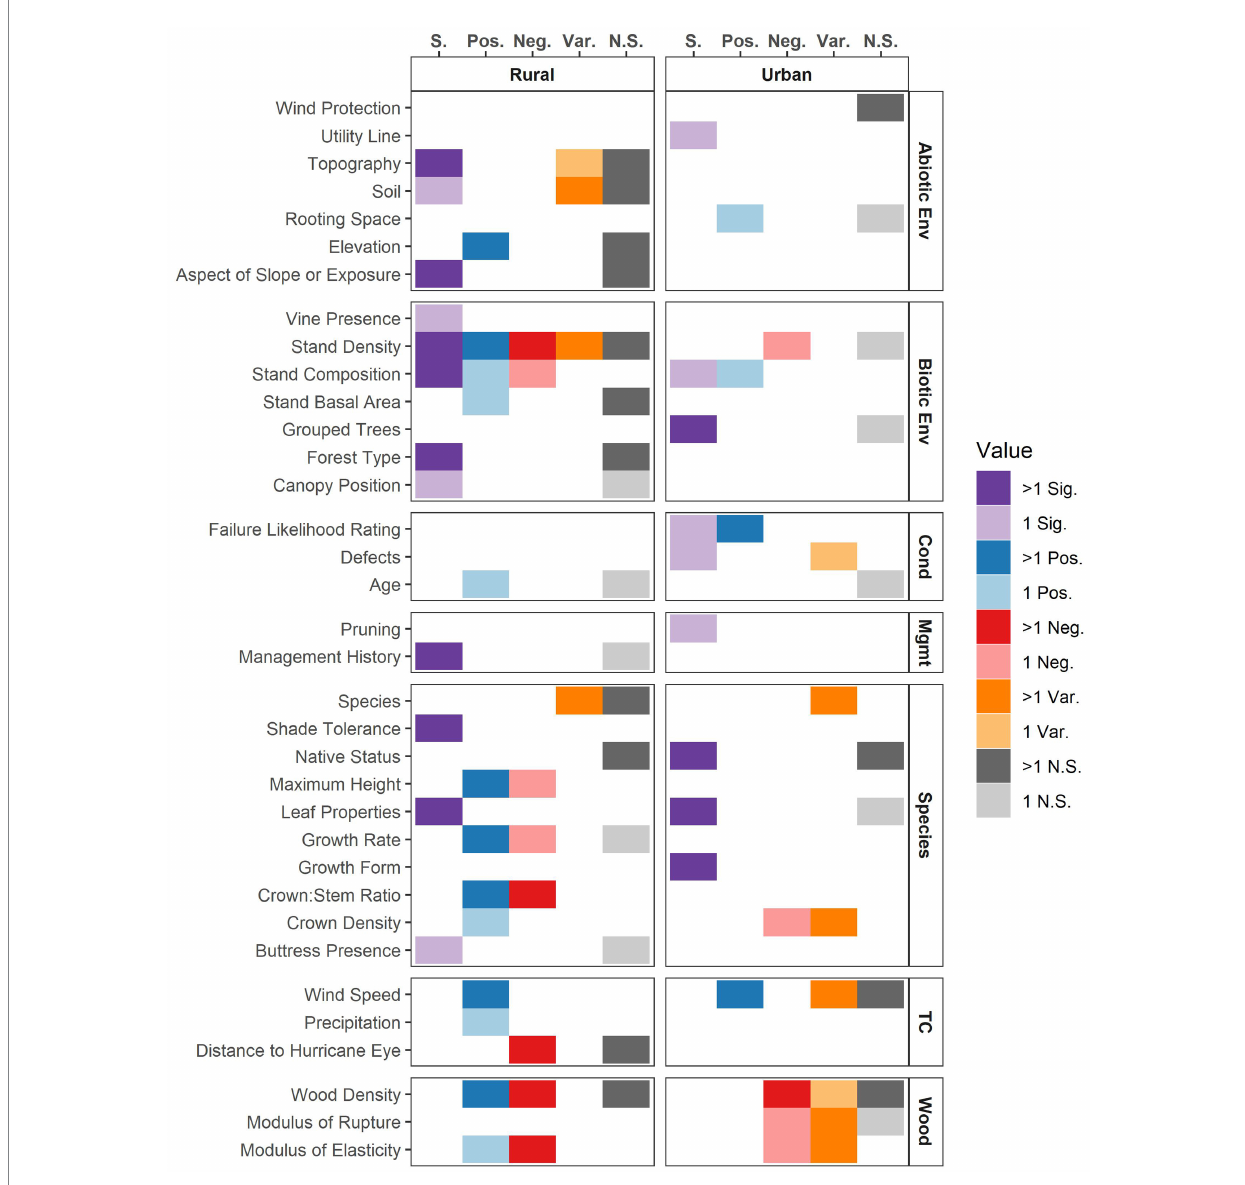
FIGURE 7 The number of studies that observed positive, negative, variable, or non-significant relationships between tree size factors and different types of tropical cyclone damage to trees. >1 indicates relationship type was observed in more than one study. Pos., positive relationship; Neg., negative relationship; Var., variable relationship (e.g., non-linear); N.S., no significant